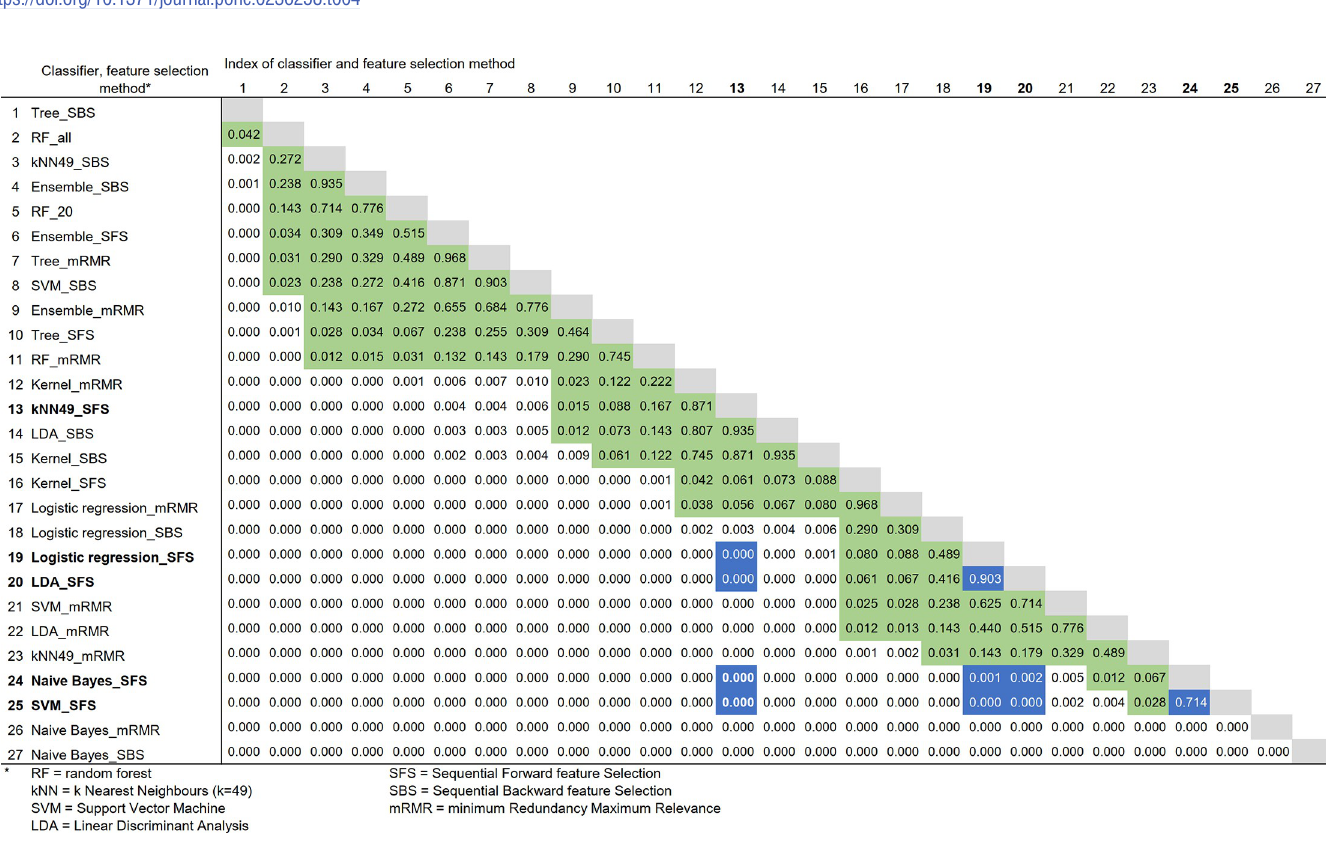
Fig 7. Statistical testing results for Cochran’s Q test and post-hoc test with pairwise comparison of individual step classification. P-values above 0.01 are marked with green background, and the best five classifiers compared are marked with blue background and white text. The classifier names with the highest accuracy are also bolded. The classifier pairs are placed in the order of the